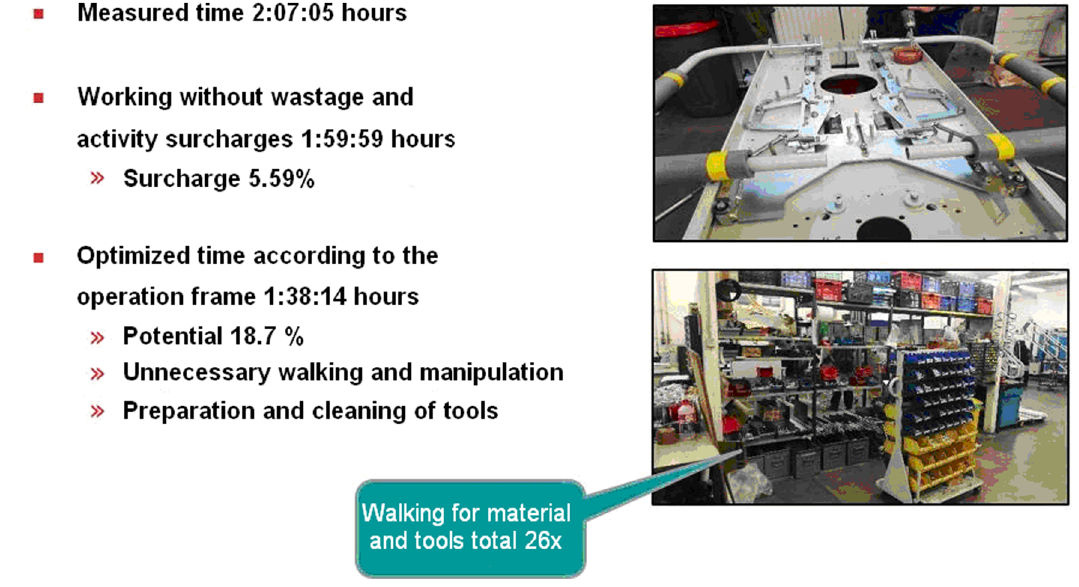
Figure 4: Time consumption example for mechanic worker 1.